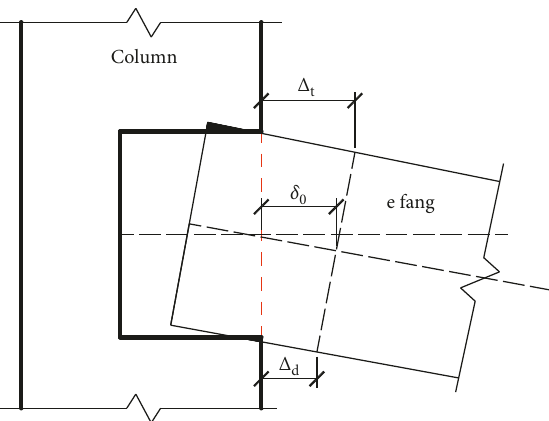
Figure 4: Tenon deflection under upward loading.